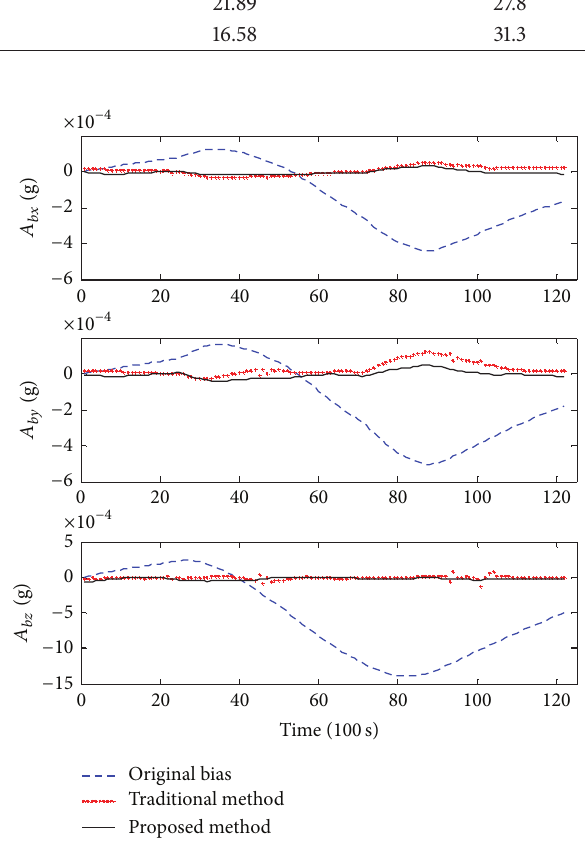
Figure 8: Curves of QMA bias changing with